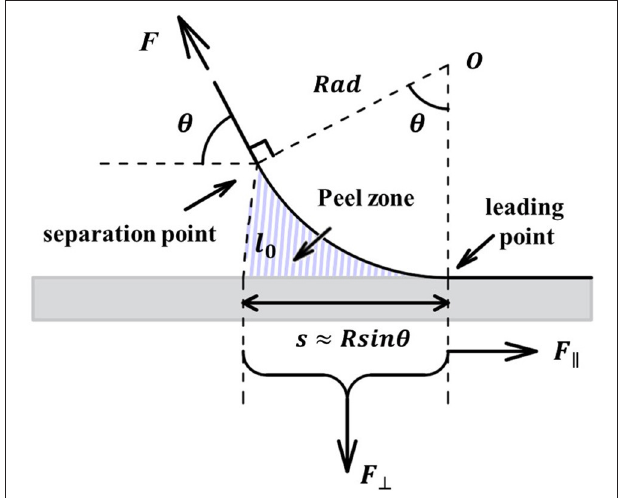
FIGURE 6 | Schematic of the peel zone in the PZ model [modified from Pesika et al. (2007) ].